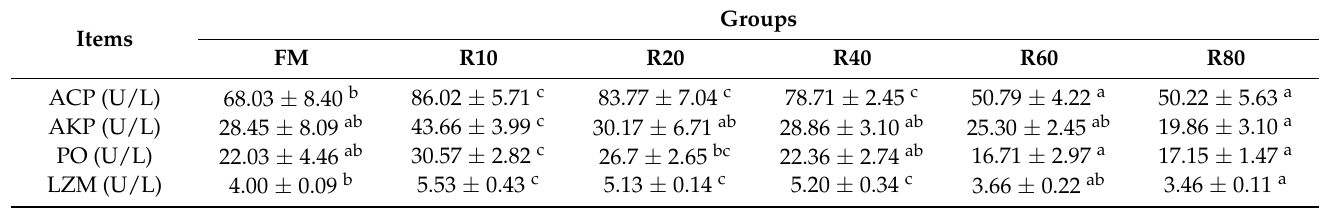
Table 7. Effects of RPM replacing fishmeal on serum non-specific immune enzyme activities for L. vannamei